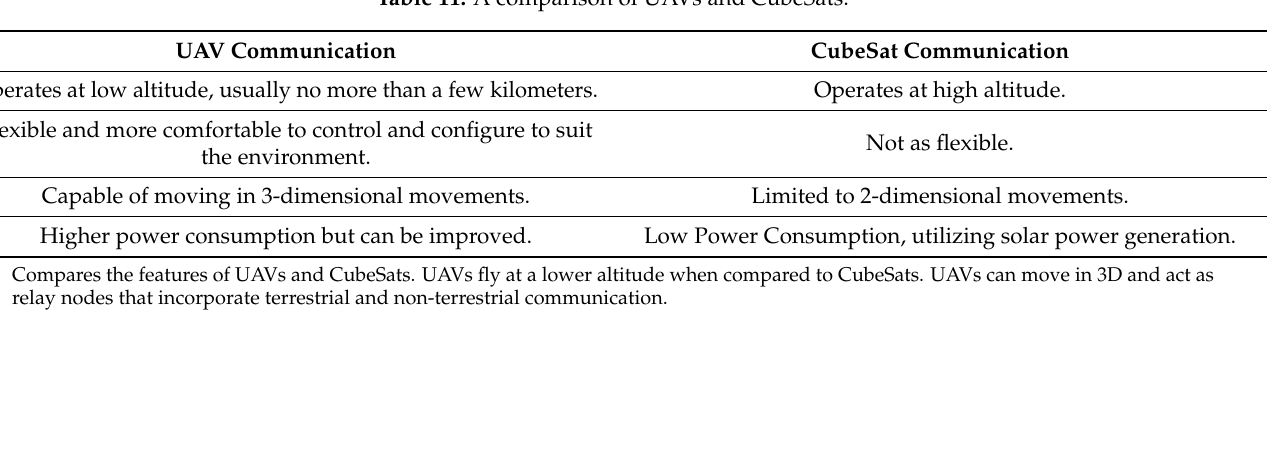
Table 11. A comparison of UAVs and